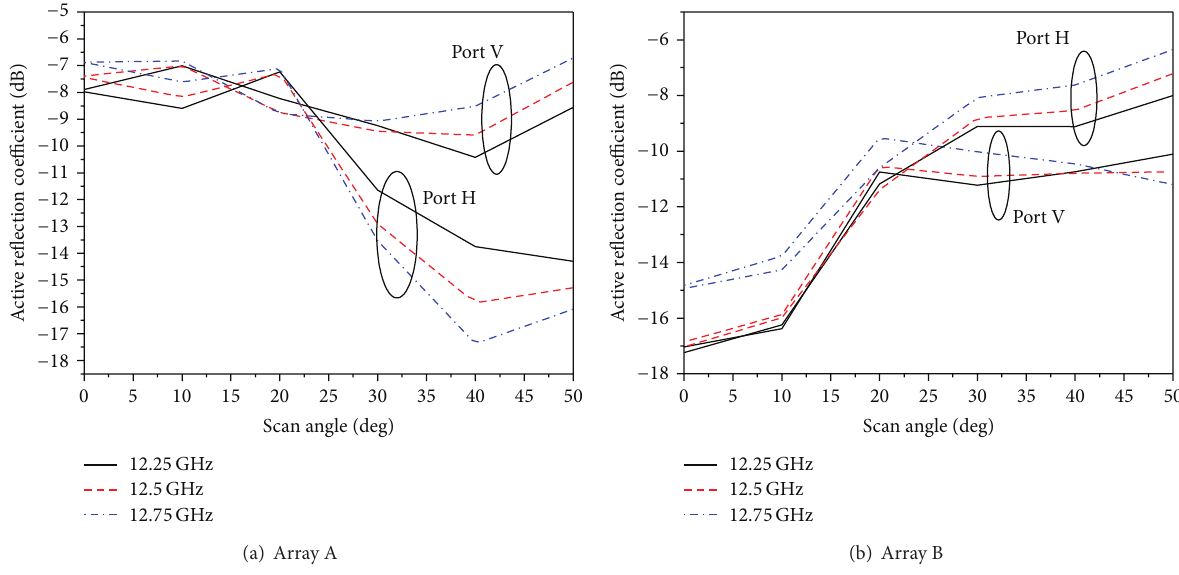
Figure 6: The active reflection coefficient of central element R5-3 (azimuth angle 𝜑 = 0 ∘ , diagonal polarization).